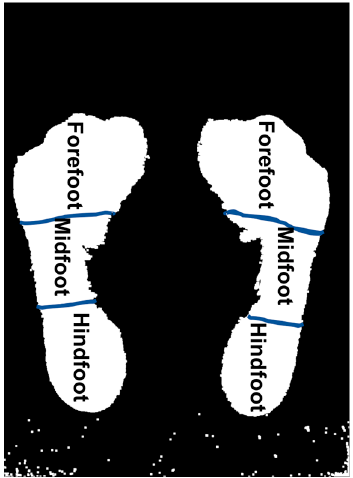
Figure 5. Divisions of the footprint in 3 zones.